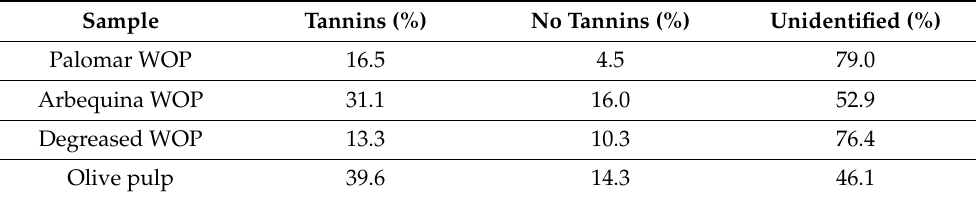
Table 4. Semi-quantification of tannin content of the five fractions of WOP by